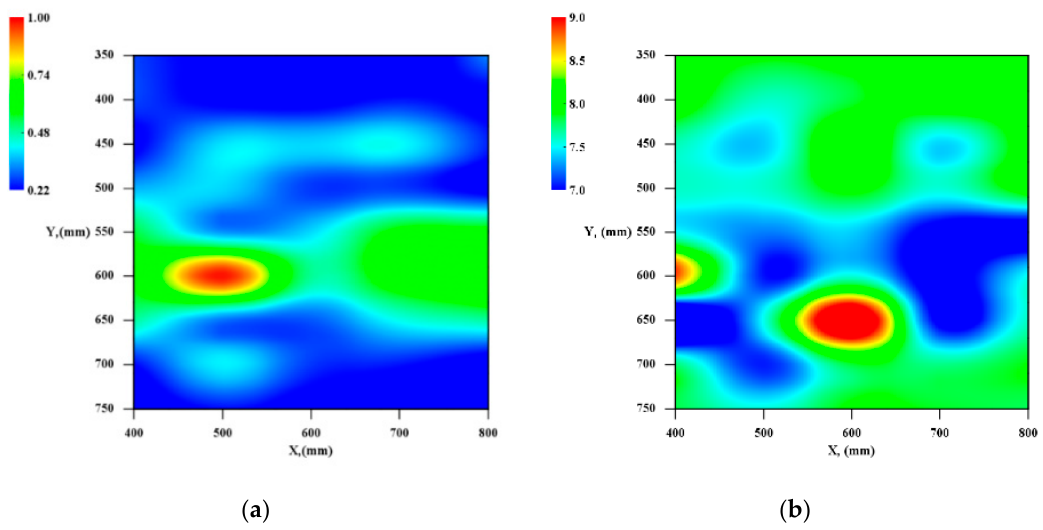
Figure 21. Contours of the evaluation results for Case_1: ( a ) DVA; ( b ) Dominant frequency.